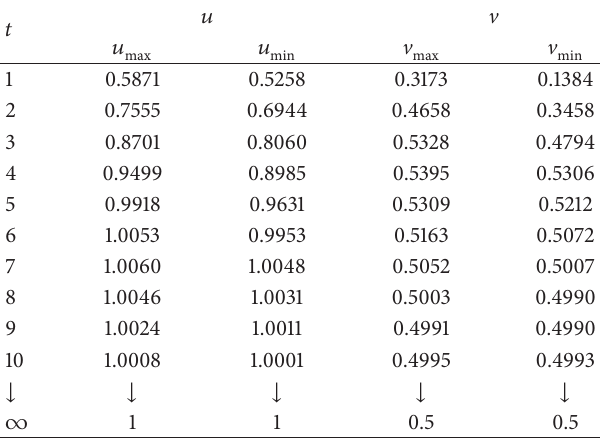
Table 1: The maximum and minimum values of the exact solution by using Crank-Nicolson method: 𝑚 = 10, Δ𝑡 = 0.1 , and 𝑁 = 25